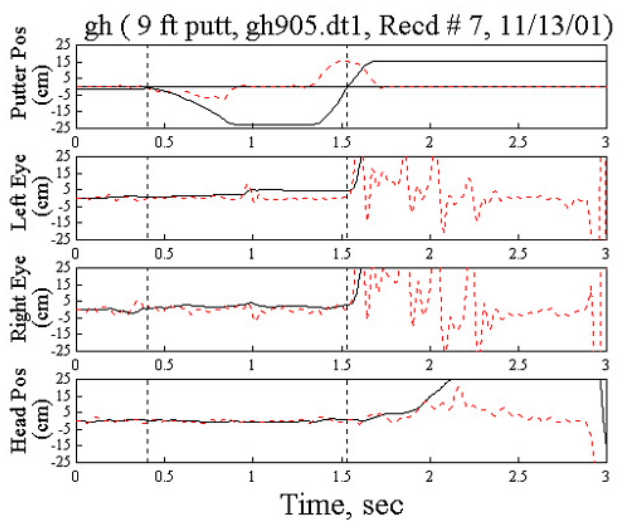
Figure 9C . Time traces for a typical 9-ft putt using the one-handed grip. Sub.